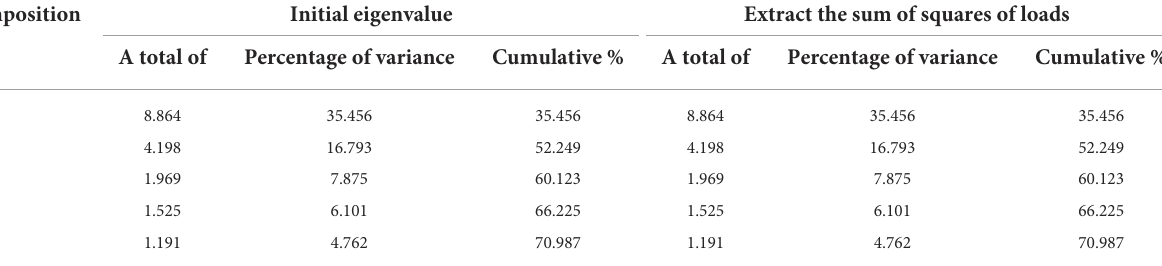
TABLE 4 Common method bias